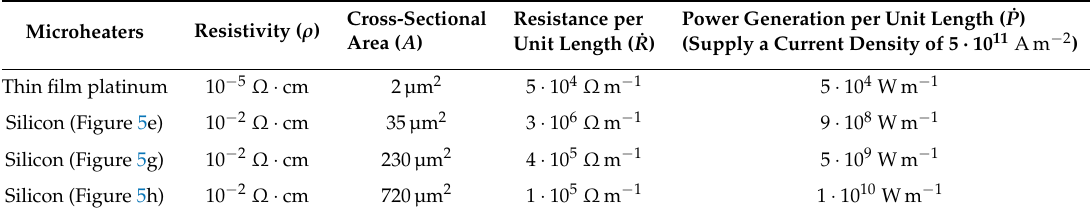
Table 2. Comparison between thin film platinum and bulk silicon as microheaters for Joule heating. At a fixed current density of 5 · 10 11 Am − 2 , silicon microheaters can dissipate much more power per unit length than the platinum